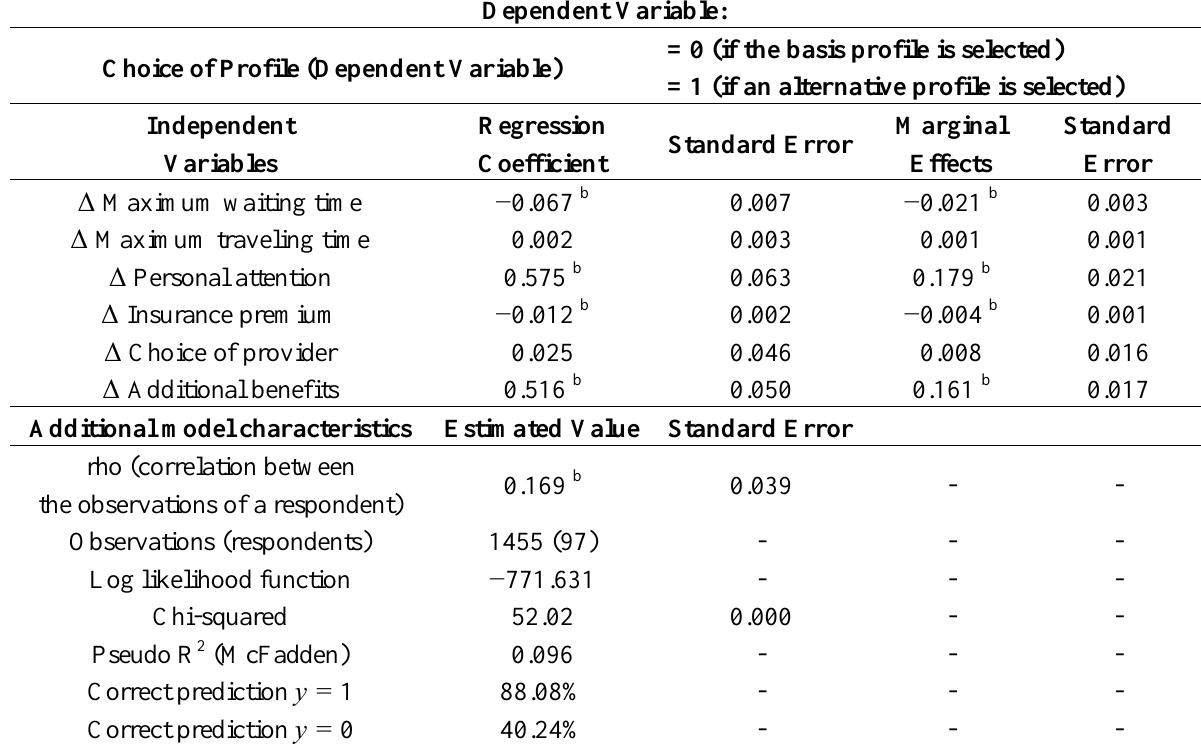
Table 7. Results of the discrete-choice experiment, main-effect model a (Δ = difference). Dependent